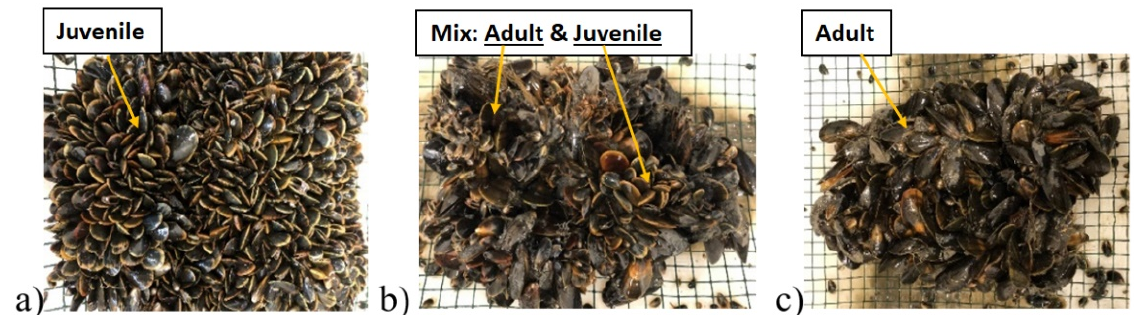
Figure 4. Experimental tube support.